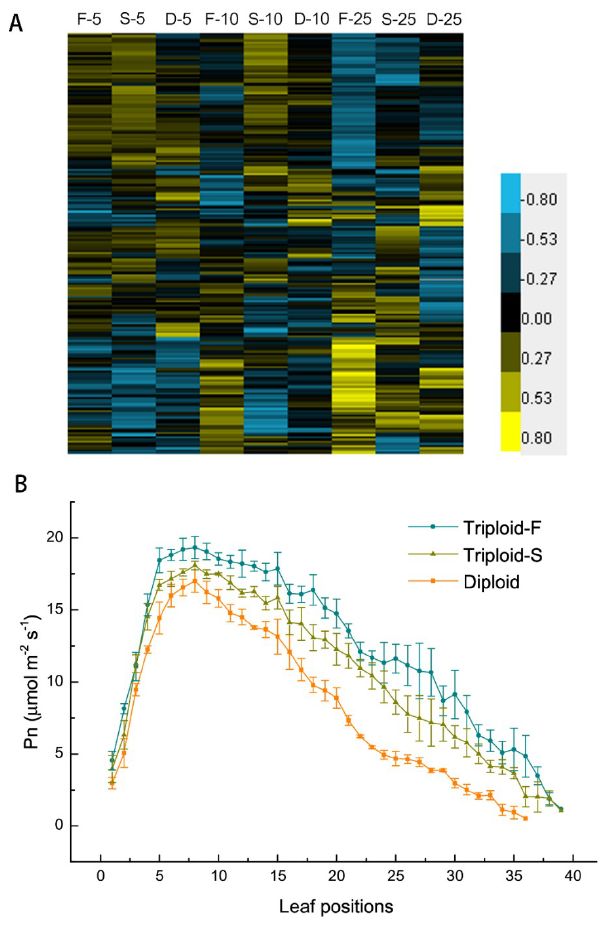
Figure 3. Photosynthesis in in triploid-F, triploid-S and diploid plants. ( A ) Di ff erentially expressed genes (DEGs) involved in light reaction and carbon fixation on di ff erent leaf canopy positions when triploid-F and triploid-S plants were compared to diploid plants; ( B ) Net rates of photosynthesis on various leaf canopy positions in triploid-F, triploid-S plants and diploid